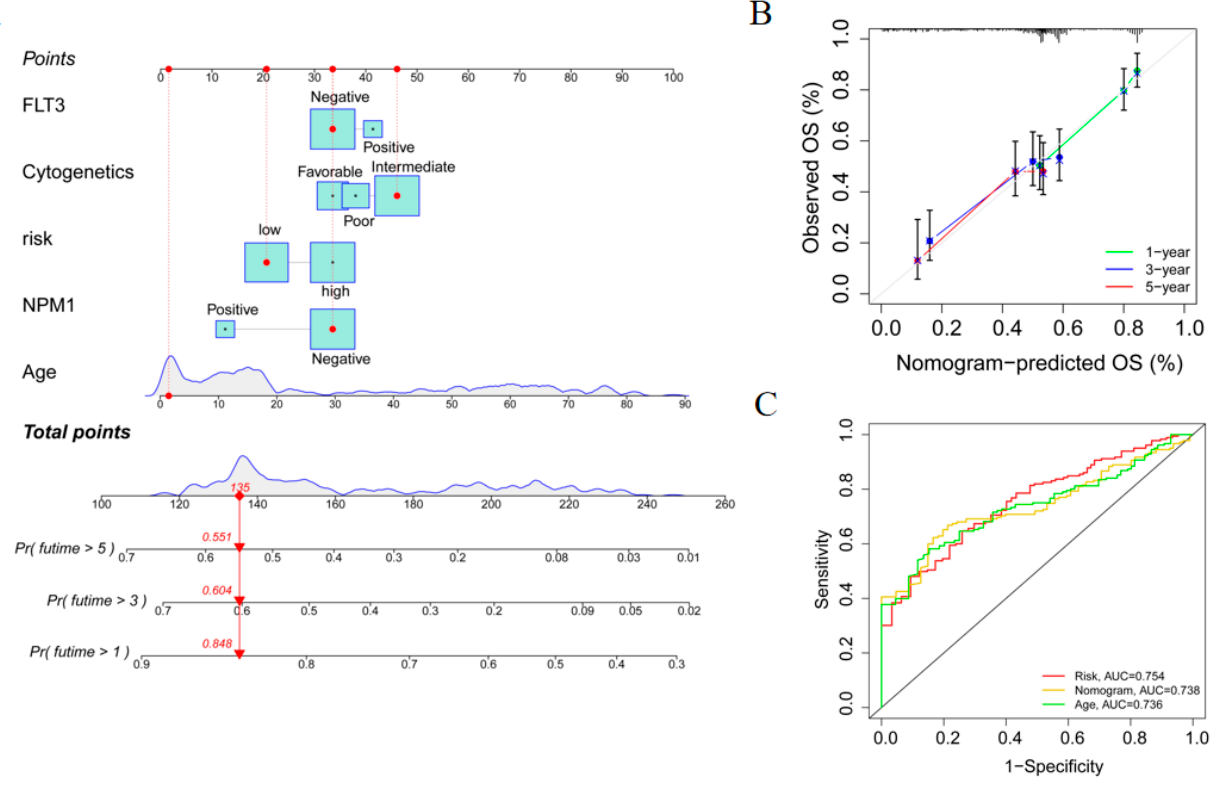
Figure 6. Construction and evaluation of the nomogram of AML patients in the TCGA-TARGET cohort. ( A ) The nomogram for predicting the probability of patient survival with risk groups and clinical features. ( B ) The calibration diagram of the nomogram for the observed overall survival (OS) probability and predicted OS at 1-year, 3-year, and 5-year intervals. ( C ) ROC curve analyses of the nomogram.